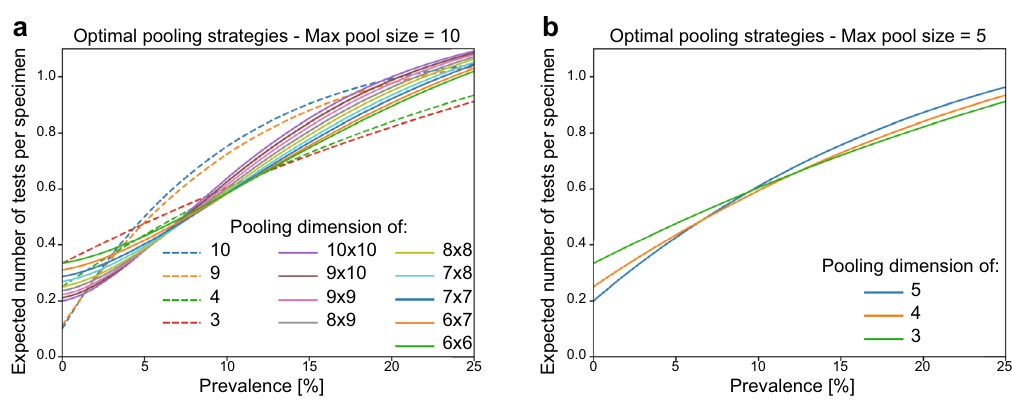
Figure 5. Optimal pooling strategies given a maximum pool size of ( a ) 10 and ( b )